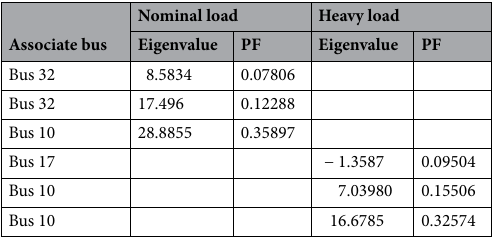
Table 6. Eigenvalue of weakest buses with SPVG PQ-model.